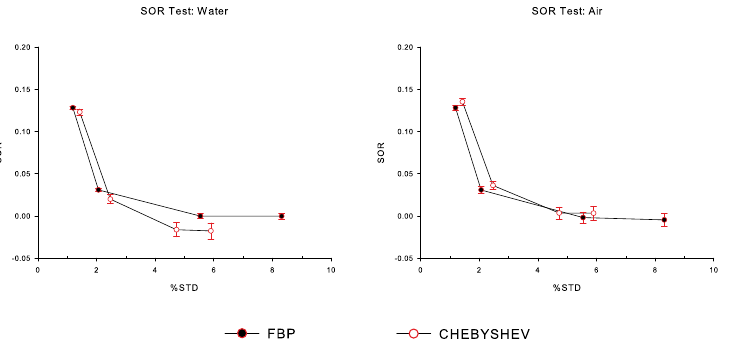
Figure 8. Spill-over ratio ( SOR ) measurements for the water-filled and air-filled chambers in the cold region of the simulated IQ phantom, as functions of percentage standard deviation (% STD ), for Chebyshev and FBP reconstructions, corresponding to all sigma values, namely from right to left: NL3 (no smoothing), 0.5 × , 1 × , and 1.5 × sigma,